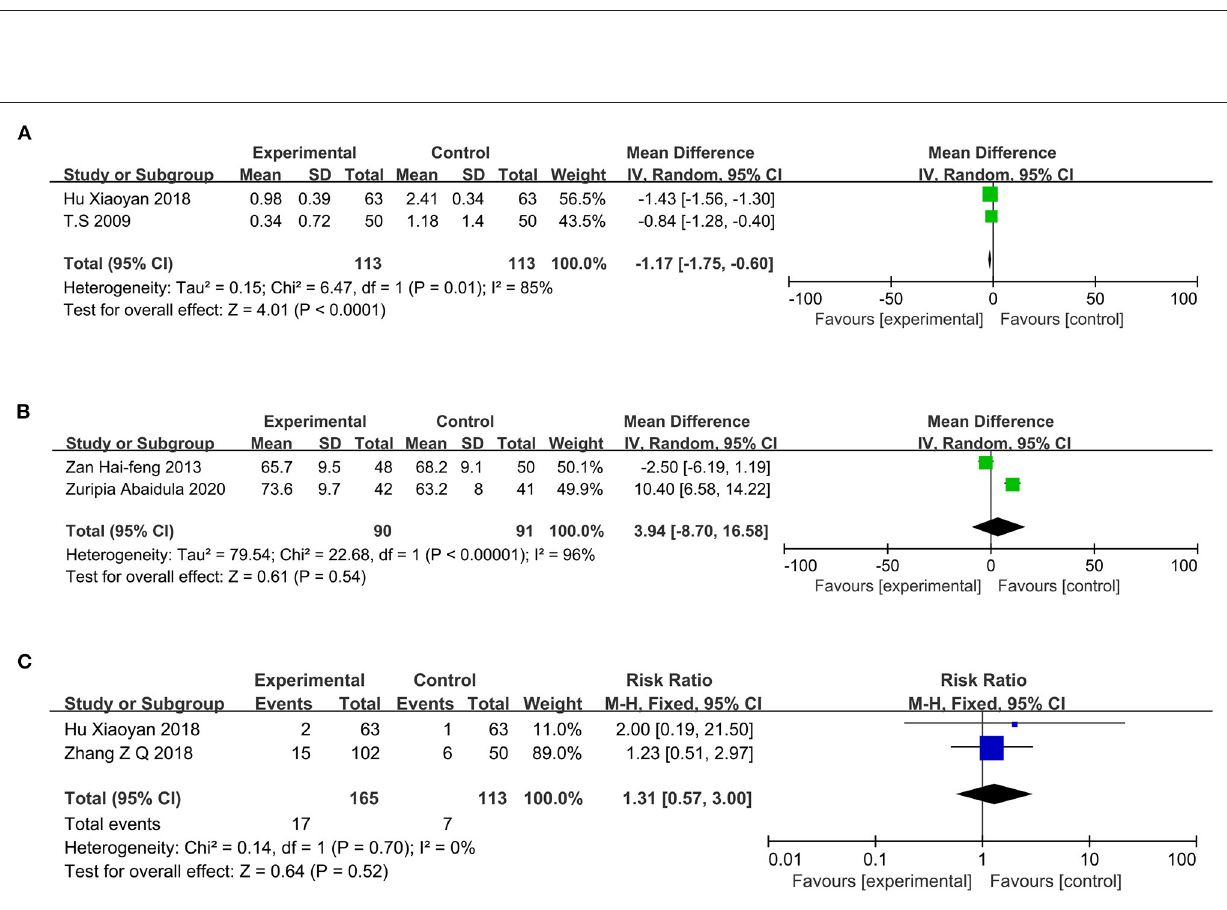
Frontiers in Medicine |